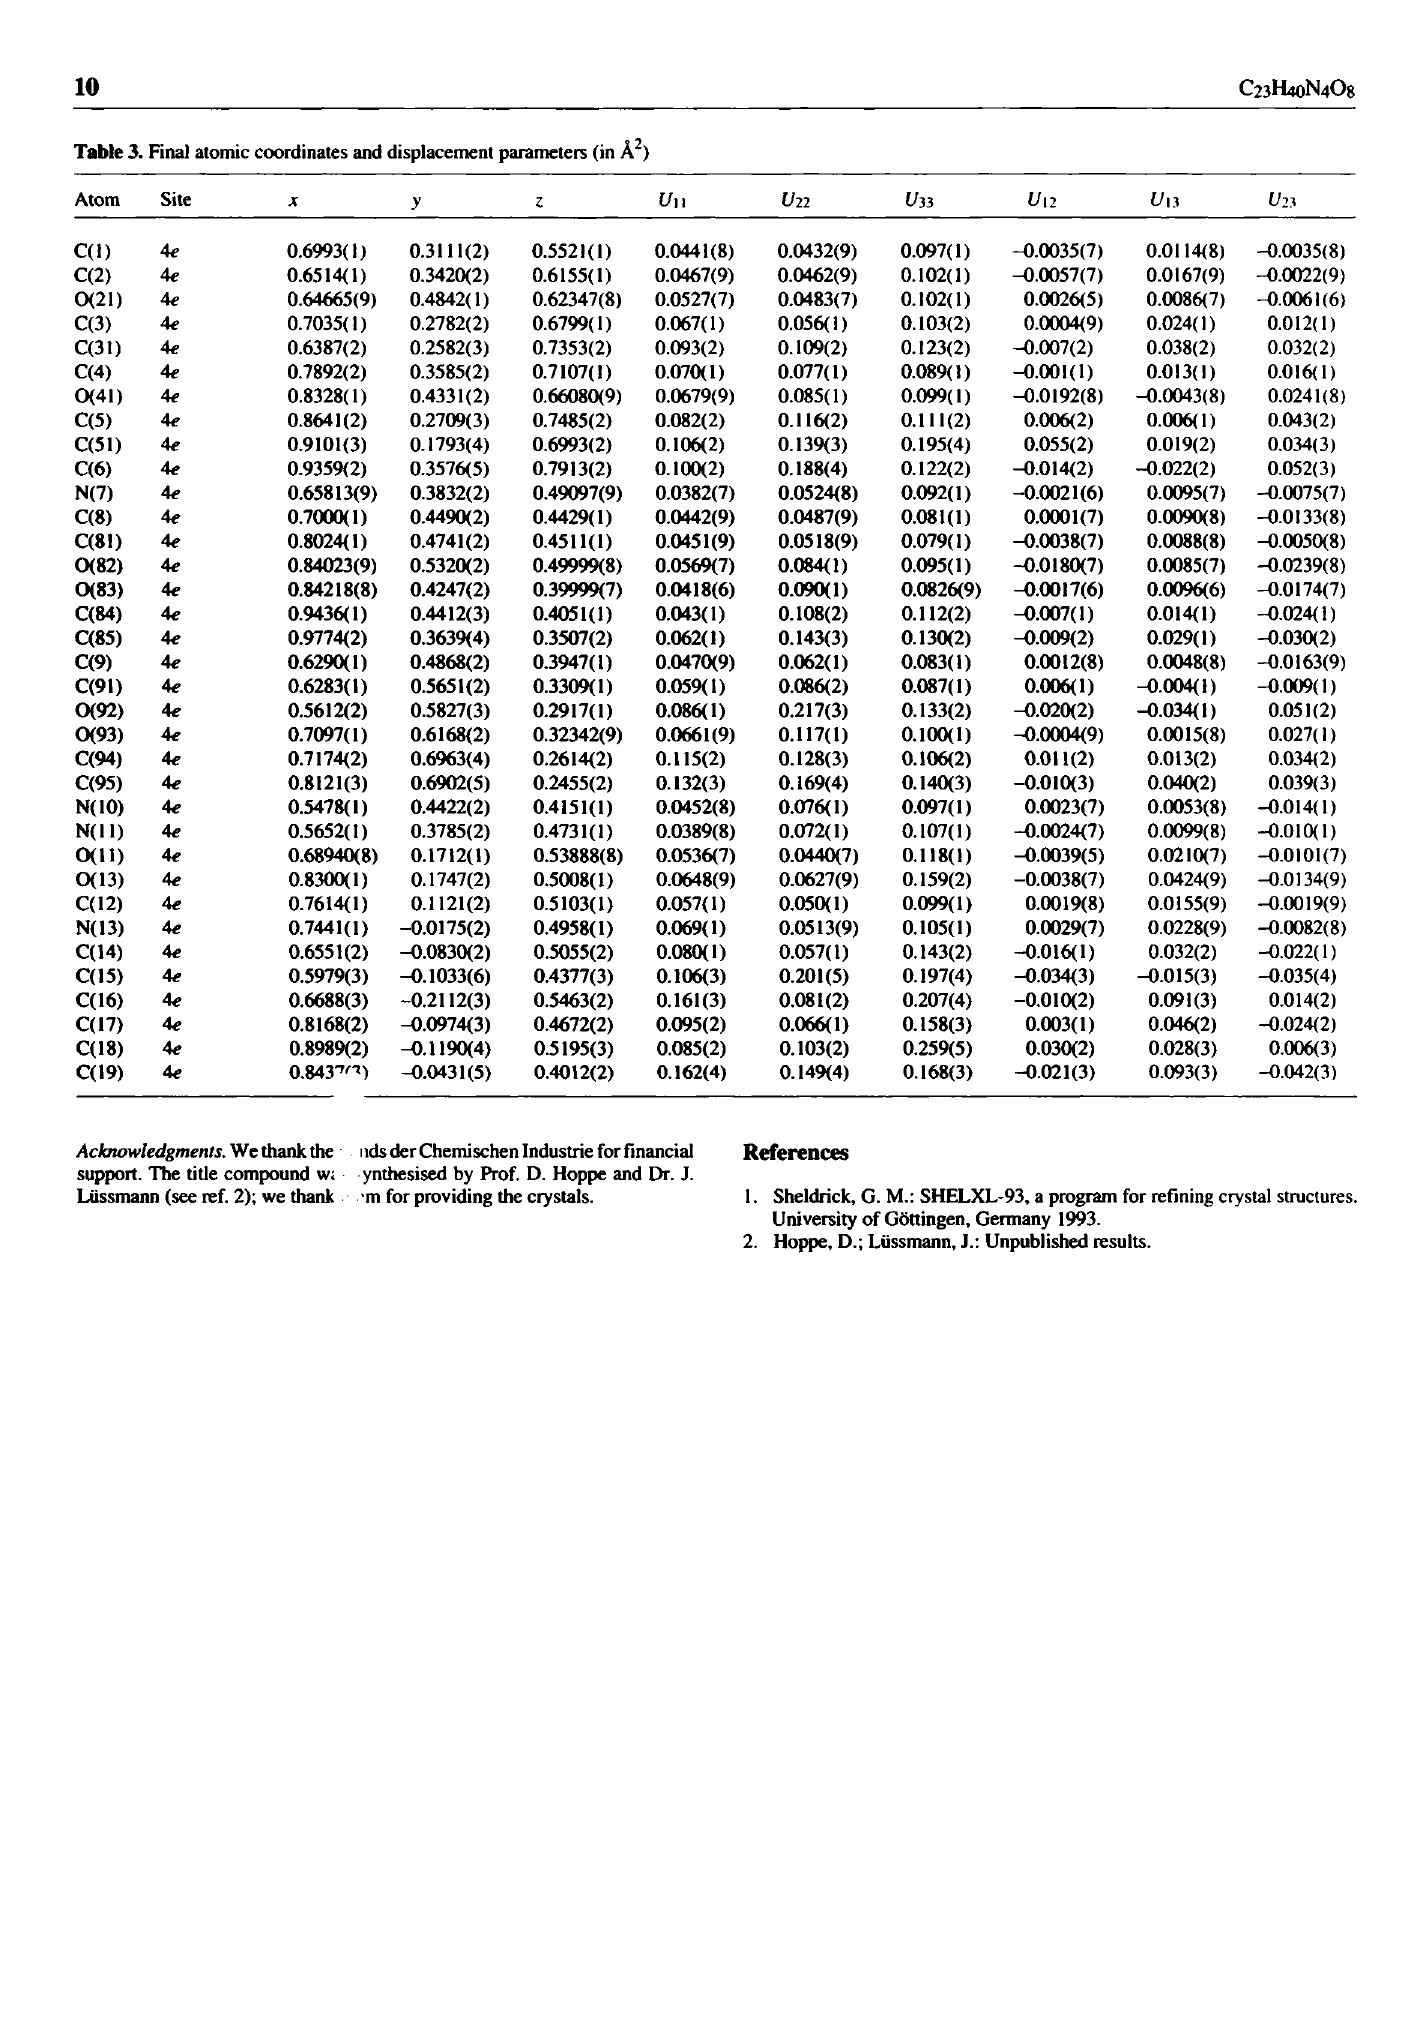
Table 3. Final atomic coordinates and displacement parameters (in Â 2